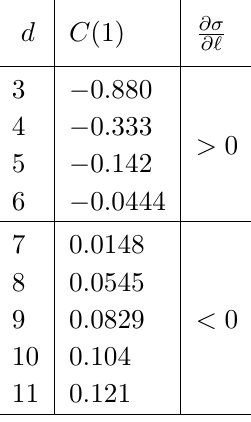
Figure 10. Holographic entanglement density (cid:27) . Table 2. Derivative of (cid:27)